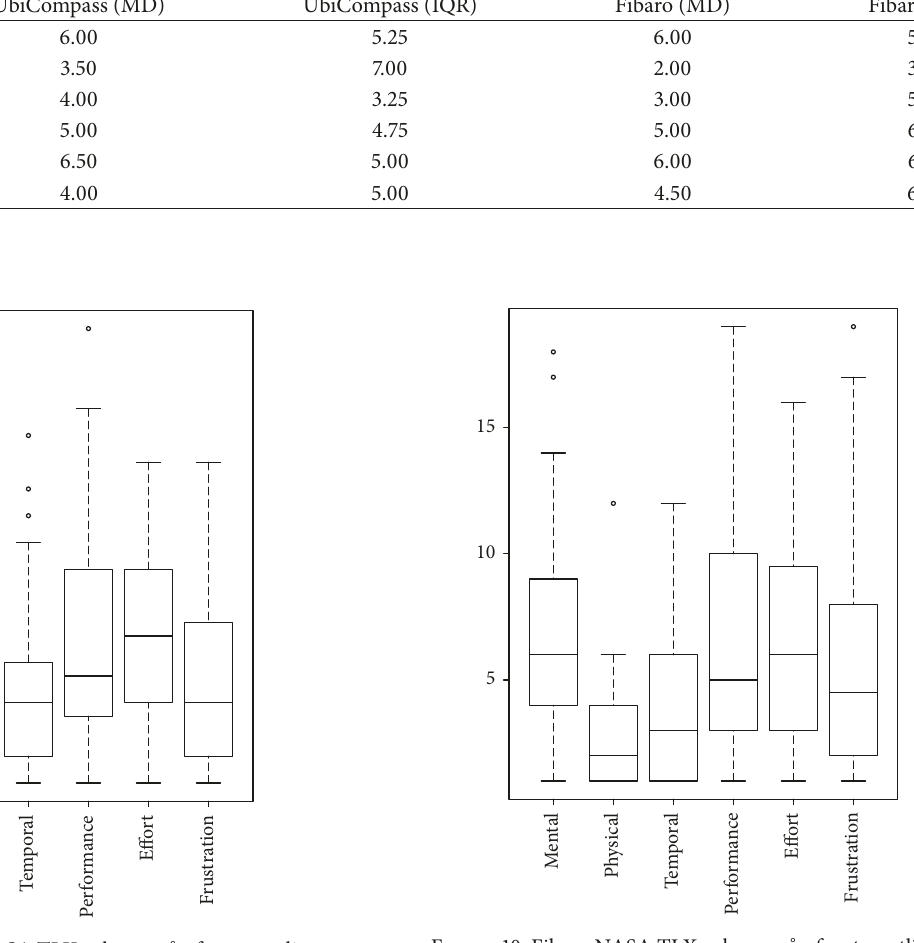
Figure 9: UbiCompass NASA TLX subscore. ∘ refers to outliers. Figure 10: Fibaro NASA TLX subscore.